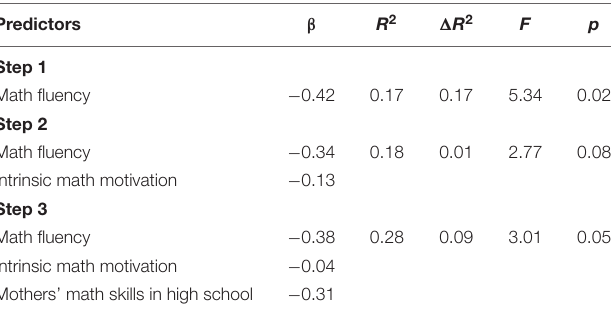
TABLE 4 | Summary of the hierarchical regression analyses to predict children’s explicitly measured math anxiety (i.e., by the AMAS self-report